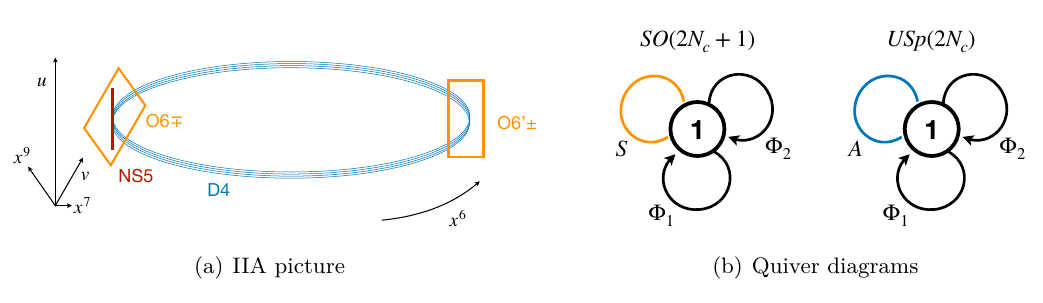
Figure 6 . N = 4 S-dual quivers with n g = 0 .